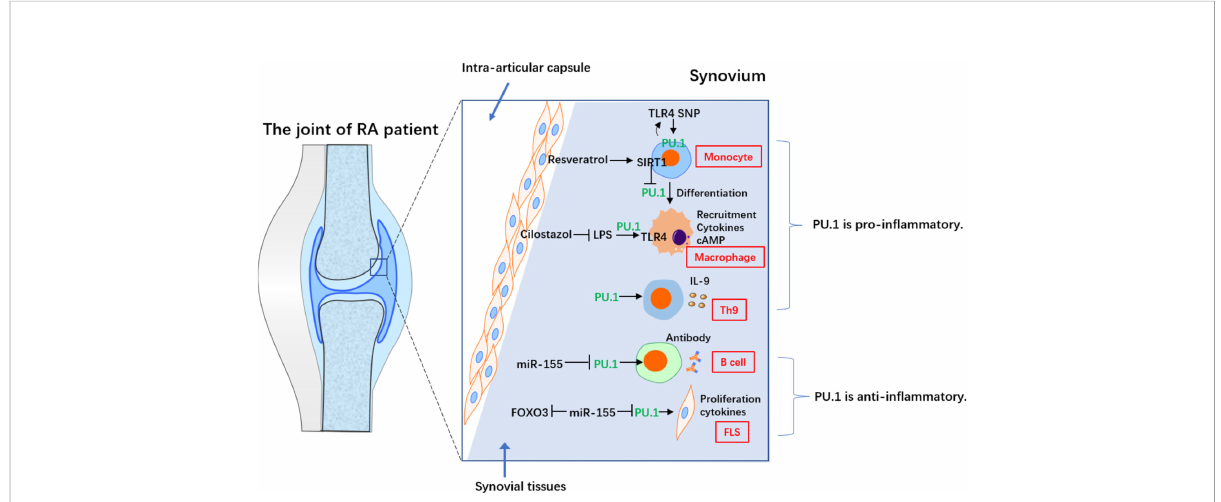
FIGURE 1 The contradictory role of PU.1 in different cells from RA. PU.1 acts as a pro-in fl ammatory factor in monocyte, macrophage and Th9 in RA. On the on contrary, PU.1 is an anti-in fl ammatory transcriptional factor in B cell and FLS in